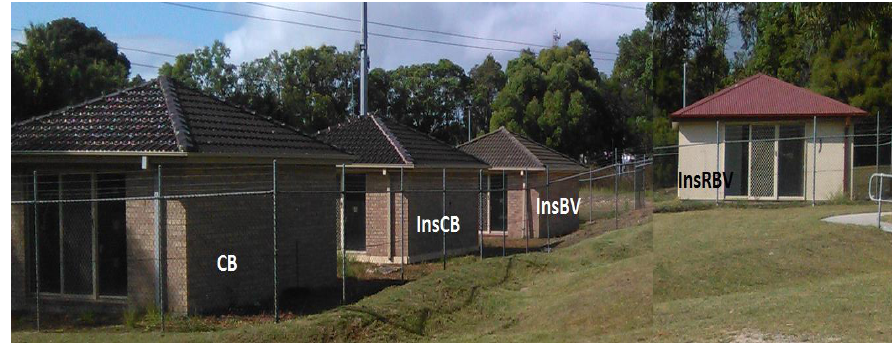
Fig. 2. Full scale test